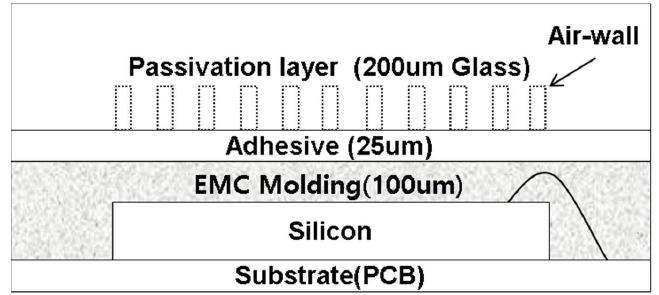
Figure 8. Cross-sectional view of the prototype with the air-wall in the passivation layer.